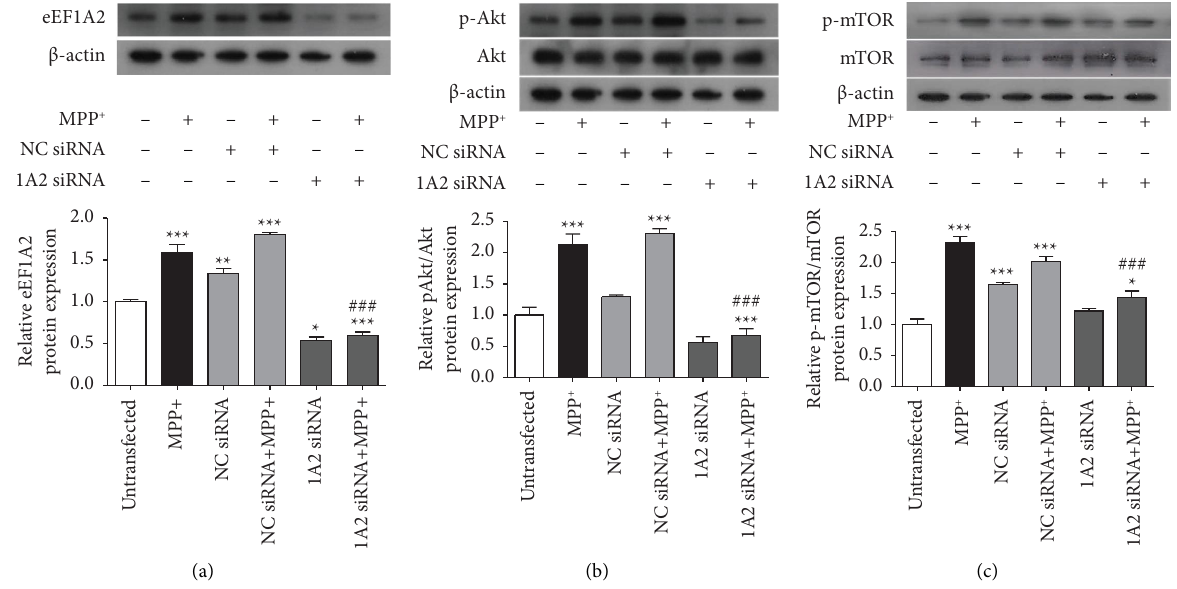
Figure 2: eEF1A2 knockdown reduces eEF1A2 expression and reduces phosphorylation of Akt1 and mTORC1 induced by MPP + . Western blot assays were performed in SH-SY5Y neuronal cells after eEF1A2 siRNA transfection and MPP + treatment. (a) Immunoblots of eEF1A2 protein. (b) Immunoblots of phospho-Akt1 protein. (c) Immunoblots of phospho-mTORC1 protein. Te density of the bands was normalized with that of β -actin protein. Data are expressed as mean ± SEM ( n � 3). ∗ p < 0 . 05, ∗∗ p < 0 . 01, ∗∗∗ p < 0 . 001 versus untransfected control; ### p < 0 . 001 versus MPP + . NC, negative control; 1A2,